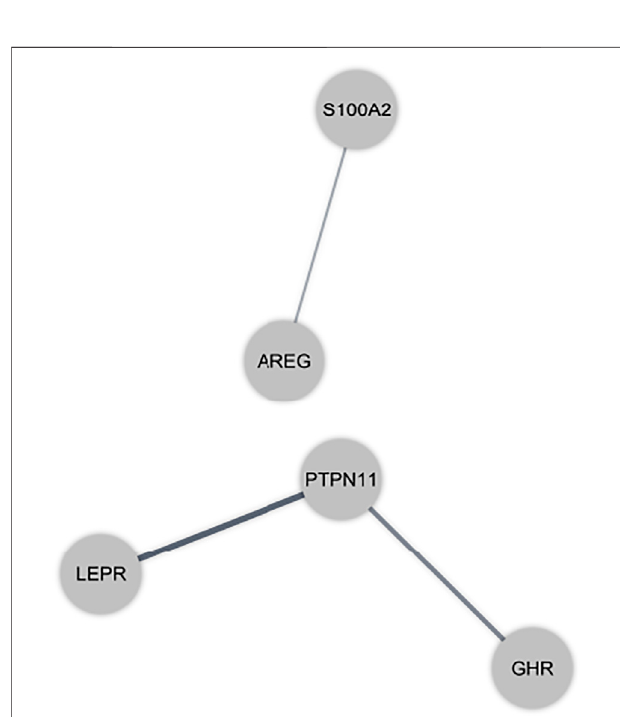
FIGURE 3 | Protein-protein interaction (PPI) network of immune-related differentially expressed mRNAs (DEmRNAs) in the peripheral blood sample of autism spectrum disorder patients. Gray nodes show the interaction among DEmRNAs in the PPI network.